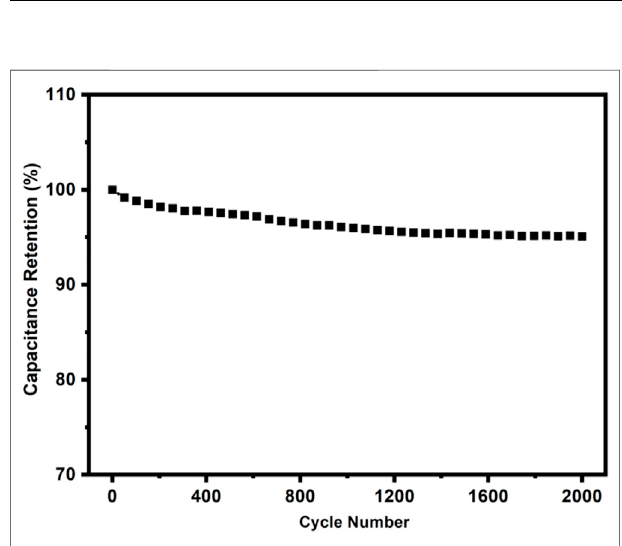
FIGURE 15 | Cyclic stability of c-4CzPN – KOH at a current density of 2 A g − 1 (retained about 95.9% after 2000 cycles).